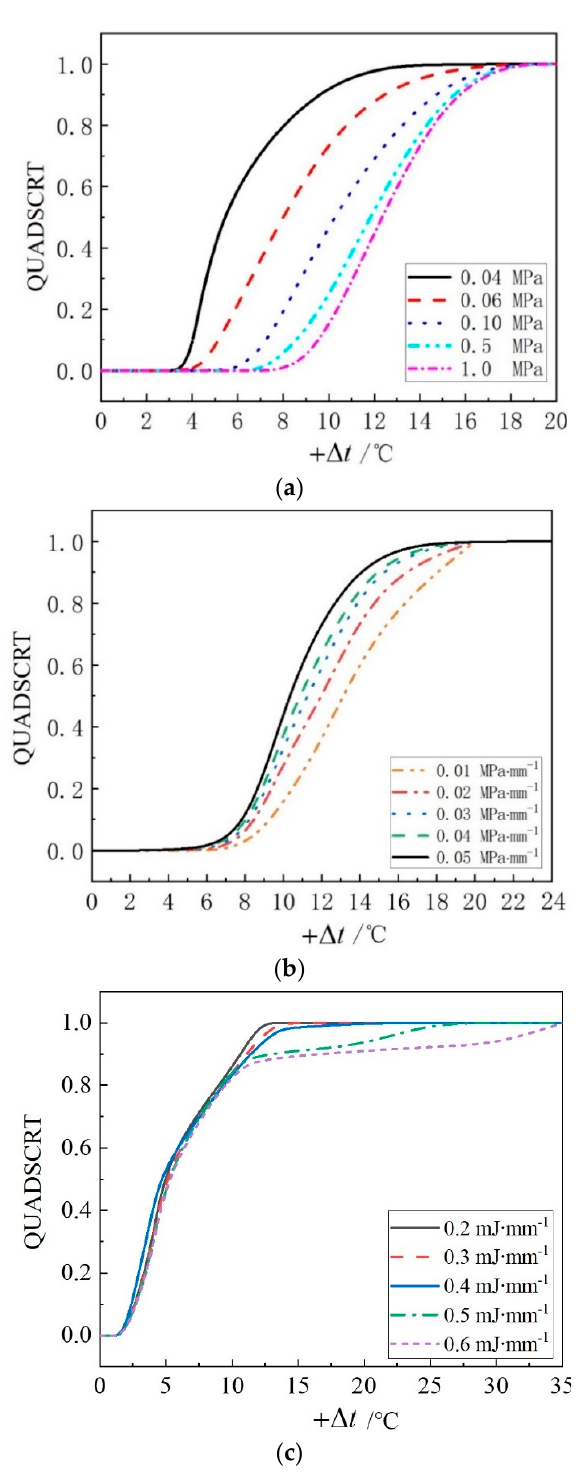
t Δ Figure 9. QUADSCRT- ∆ t curves of di ff erent interface parameters: ( a ) Impact of interfacial shear Figure 9. QUADSCRT- curves of different interface parameters: ( a ) Impact of interfacial shear strength; ( b ) Impact of interfacial shear sti ff ness; and ( c ) Impact of critical fracture strength; ( b ) Impact of interfacial shear stiffness; and ( c ) Impact of critical fracture energy.